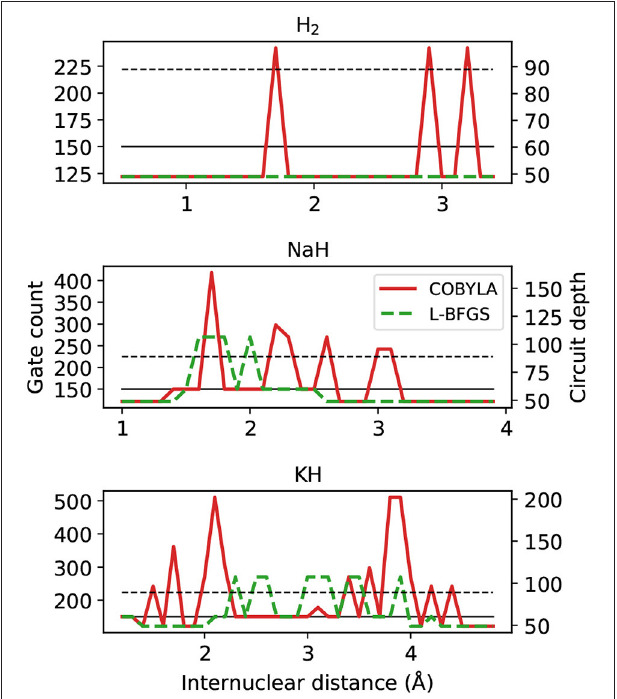
FIGURE 10 | Gate counts (left axis) and circuit depth (right axis) from ADAPT-VQE circuits optimized with the COBYLA and L-BFGS optimizers. The black solid and dashed lines are the gate counts and circuit depths from the VQE ansatz, respectively.